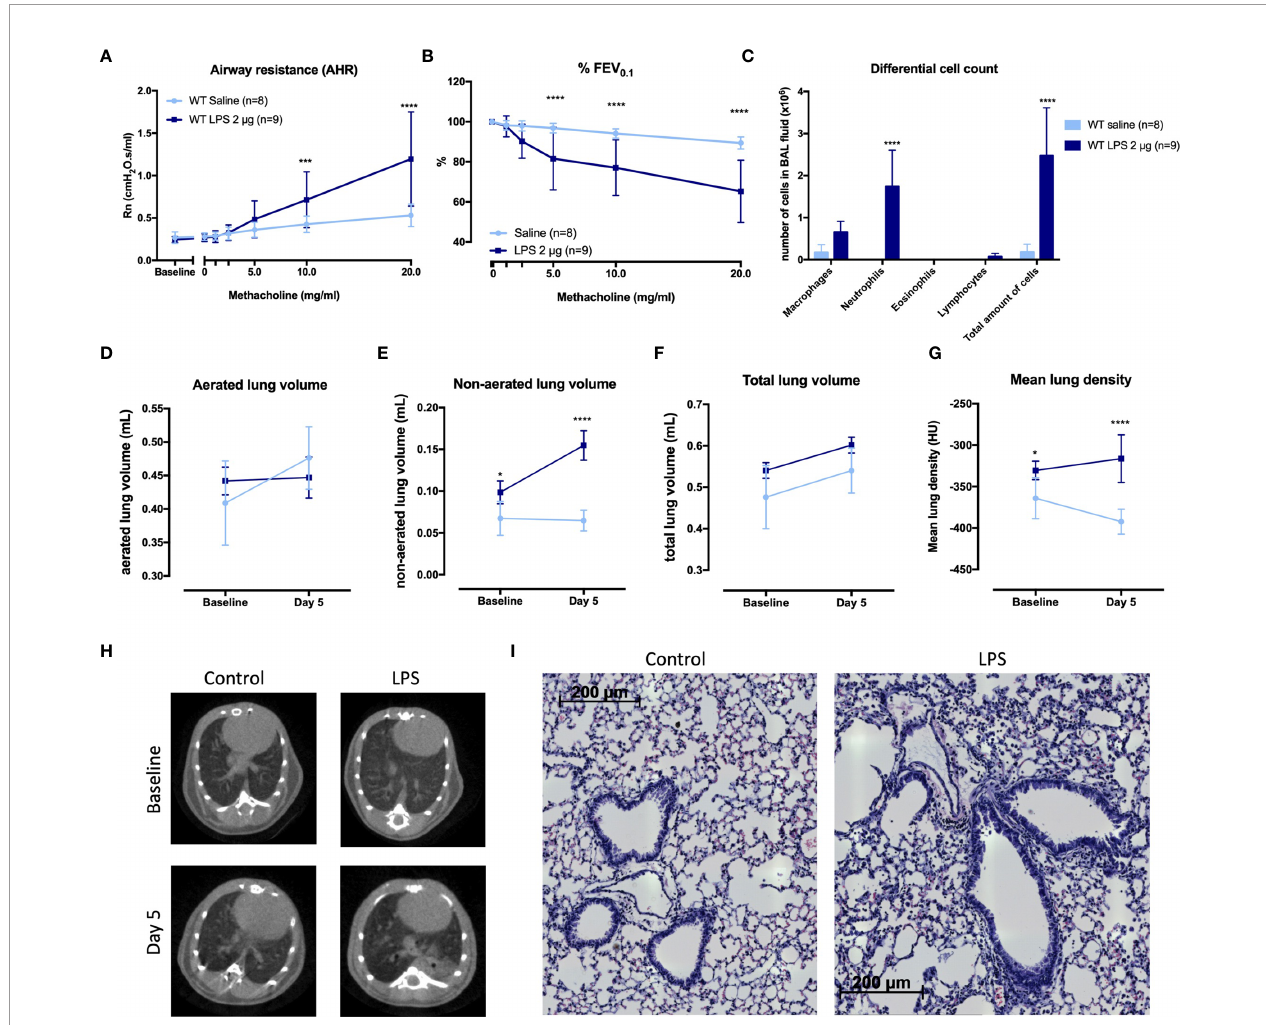
FIGURE 1 | Characterization of a murine model for neutrophilic asthma. BALB/c wild-type (WT) mice were challenged with LPS (2 µg in 50 µl saline) via the nose on four consecutive days ( Supplementary Figure 1A ). Twenty-four hours after the last challenge with LPS, lung function parameters were measured with the FlexiVent and µCT was performed. Airway resistance [Rn, (A) ] and FEV 0.1 [%, (B) ] before and after methacholine provocation (0 – 20 mg/ml) were measured in saline-treated mice (n = 8) and LPS-treated mice (n = 9) and a differential cell count (C) was performed on BAL fl uid. Results from two independent experiments were combined. µCT-derived biomarkers were measured in saline-treated mice (light blue; n = 5) and LPS-treated mice (dark blue; n = 5): the aerated lung volume (D) , non-aerated lung volume (E) , total lung volume (F) , and mean lung density (G) . Representative µCT images at baseline (before saline or LPS challenges) and at day 5 are shown in (H) for control (saline-treated) mice and LPS-treated mice. Representative images of hematoxylin and eosin staining of lung tissue of saline-exposed and LPS- exposed mice at day 5 are shown in (I) (magni fi cation ×40). Data are represented as mean with standard deviation. Two-way ANOVA was used to compare groups. *p < 0.05; ***p < 0.001; ****p < 0.0001. HU, Houns fi eld unit; LPS,